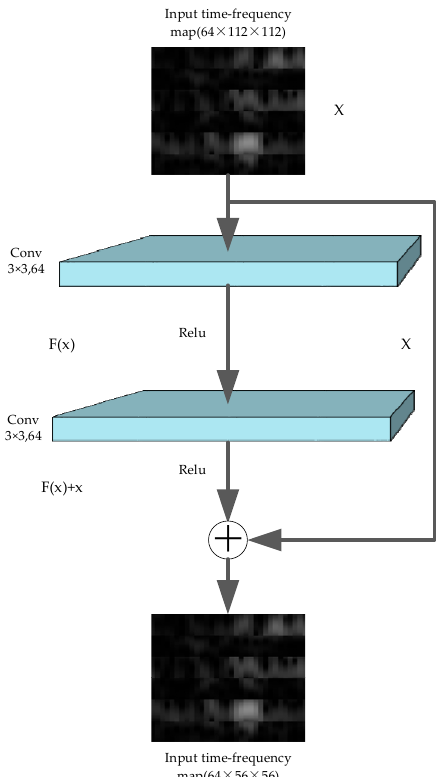
Figure 4. 3 × 3 Diagram of the deformable convolutional operation mechanism.